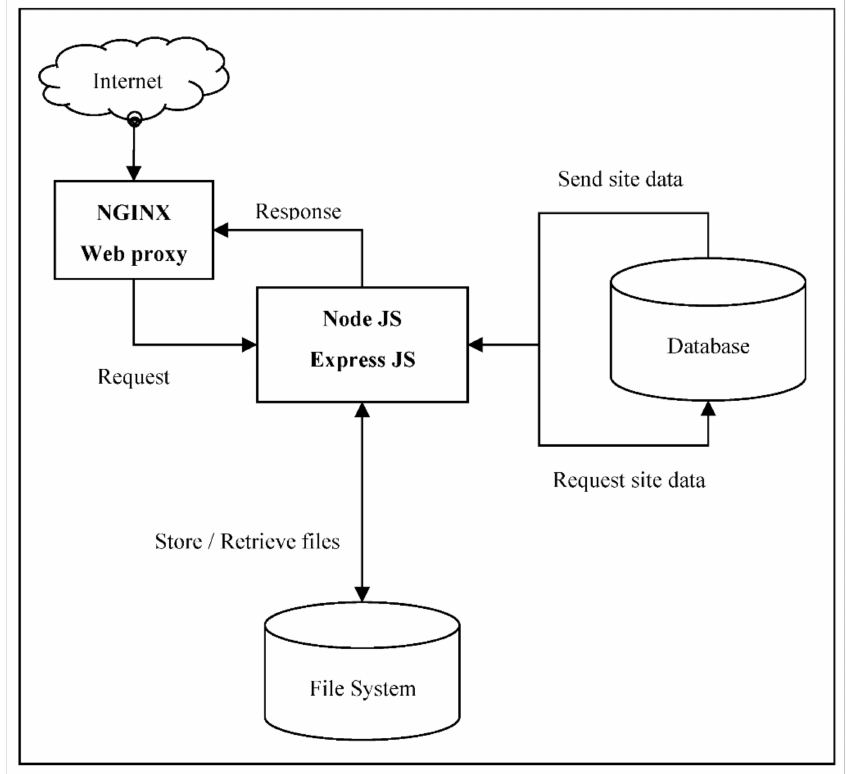
Figure 12. The application server internal structure and functional